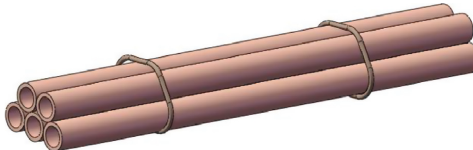
Figure 1: Schematic diagram of the